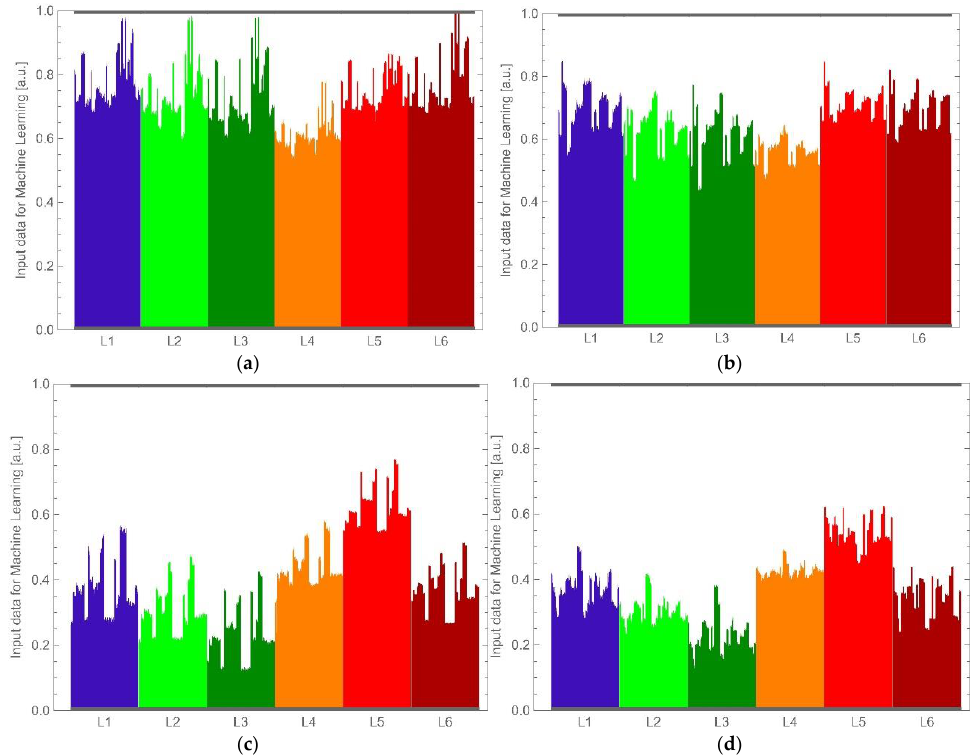
Figure 10. Exemplary final data graph for the samples of the categories ( a ) “healthy white”, ( b ) “infected white”, ( c ) “healthy brown” and ( d ) “infected brown”.